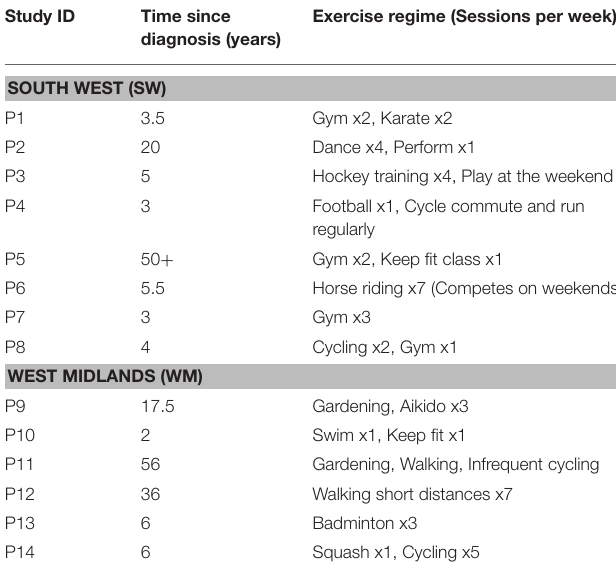
TABLE 1 | Patient participants. Study ID Time since Exercise regime (Sessions per diagnosis (years)